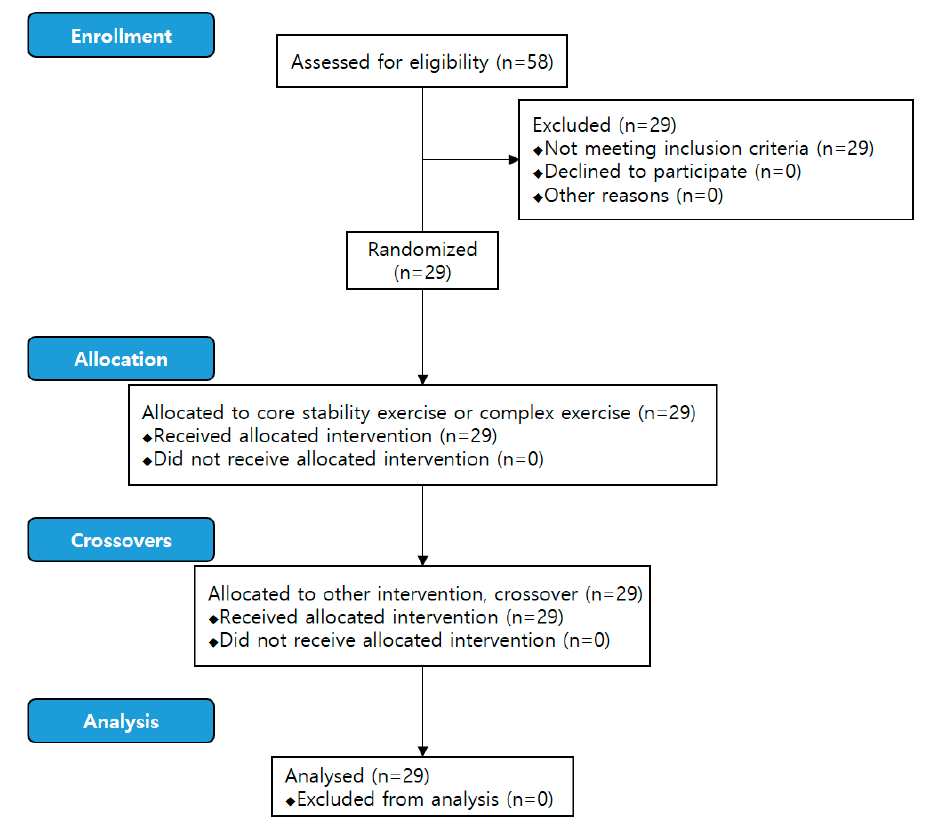
Figure 1. CONSORT flow chart.